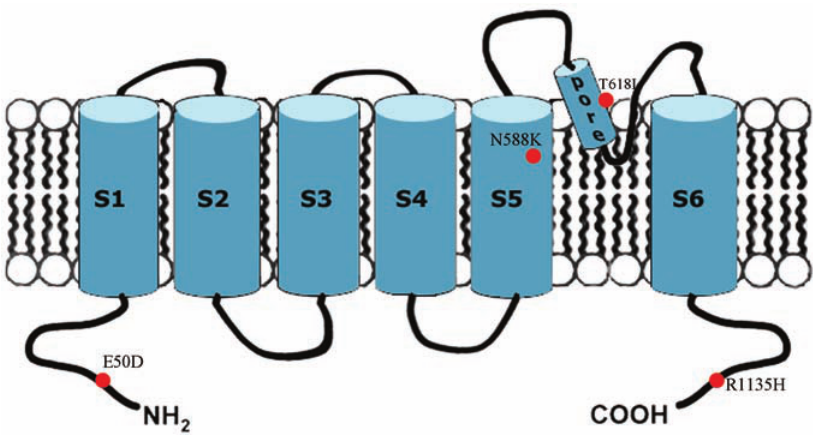
Figure 2. KCNH2 -HERG channel subunit. Localization of the described